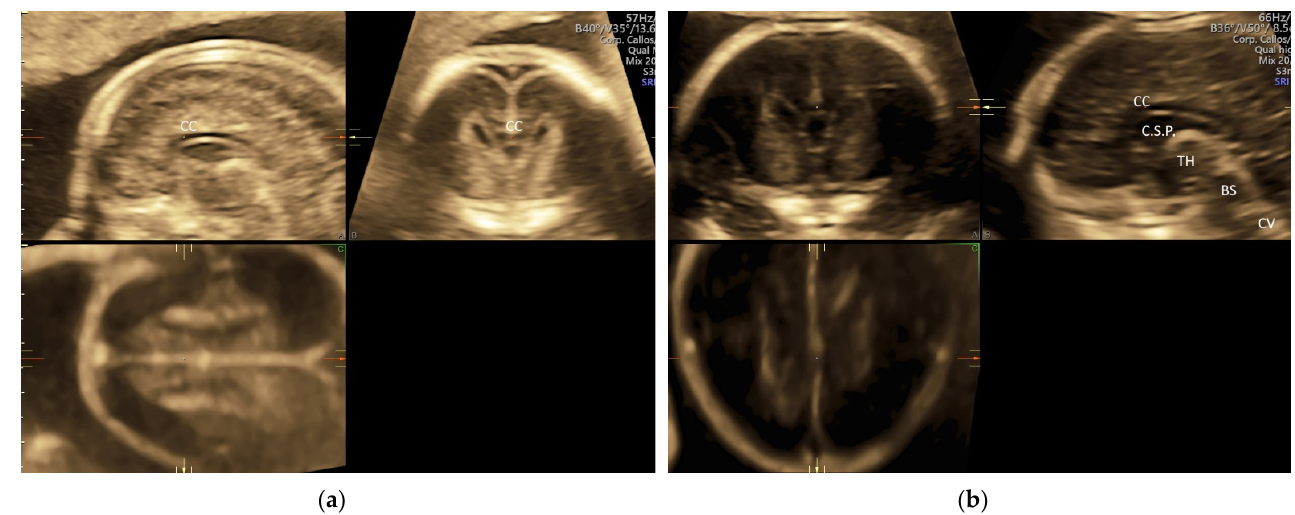
Figure 7. Three-dimensional ultrasonography of fetal brain at 20 weeks’ gestation: ( a ) multiplanar analysis after a volume acquisition with corpus callosum mode through the anterior part of the sagittal suture showing corpus callosum (CC), and ( b ) multiplanar analysis after a volume acquisition through the posterior fontanelle showing corpus callosum (CC), cavum septi pellucidi (C.S.P.), thalamus (TH), brainstem (BS), and cerebellar vermis (CV).